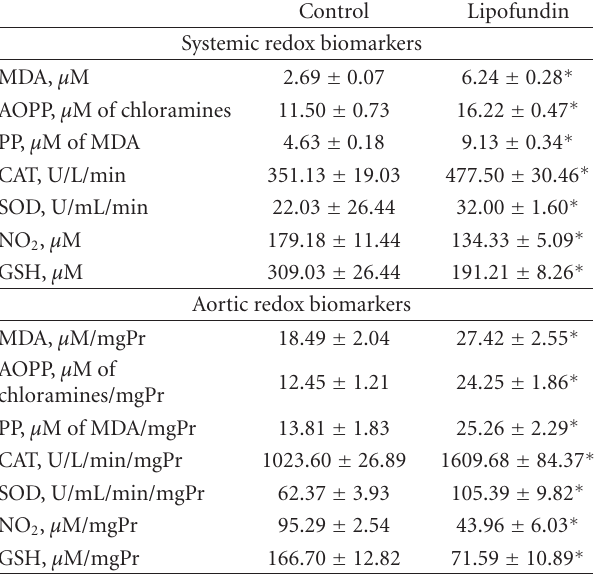
Table 2: E ff ects of Lipofundin on redox biomarkers. Values repre- sent the mean ± standard deviation. Asterisks represent statistical di ff erences ( P < 0 . 05). The concentration of aortic parameters is expressed per milligrams of total proteins